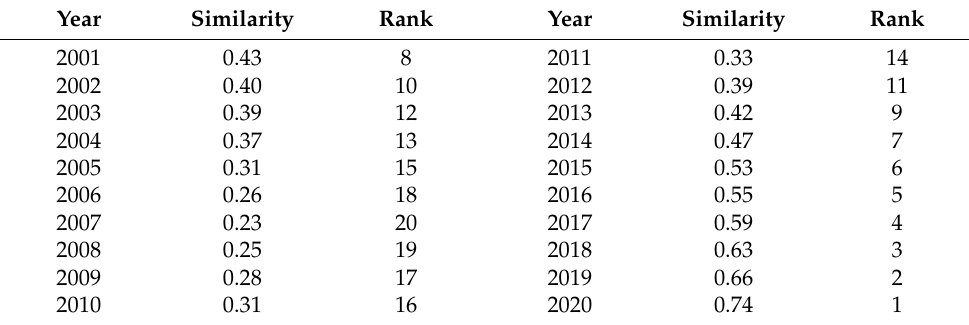
Figure 2. Changes in China’s Food Security Index from 2001 to 2020. Table 4. Overall food security index and its ranking, 2001–2020.